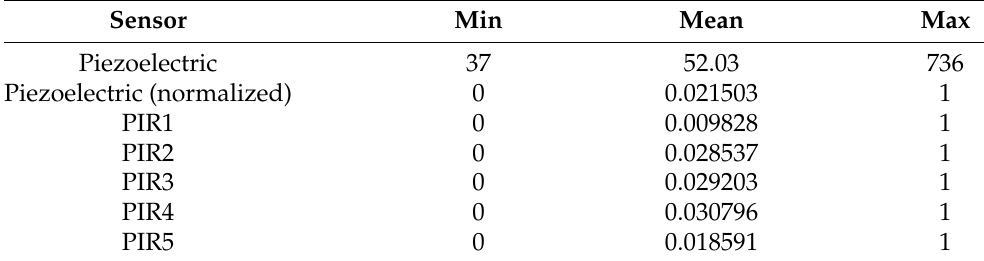
Table 1. Summary of the sensor